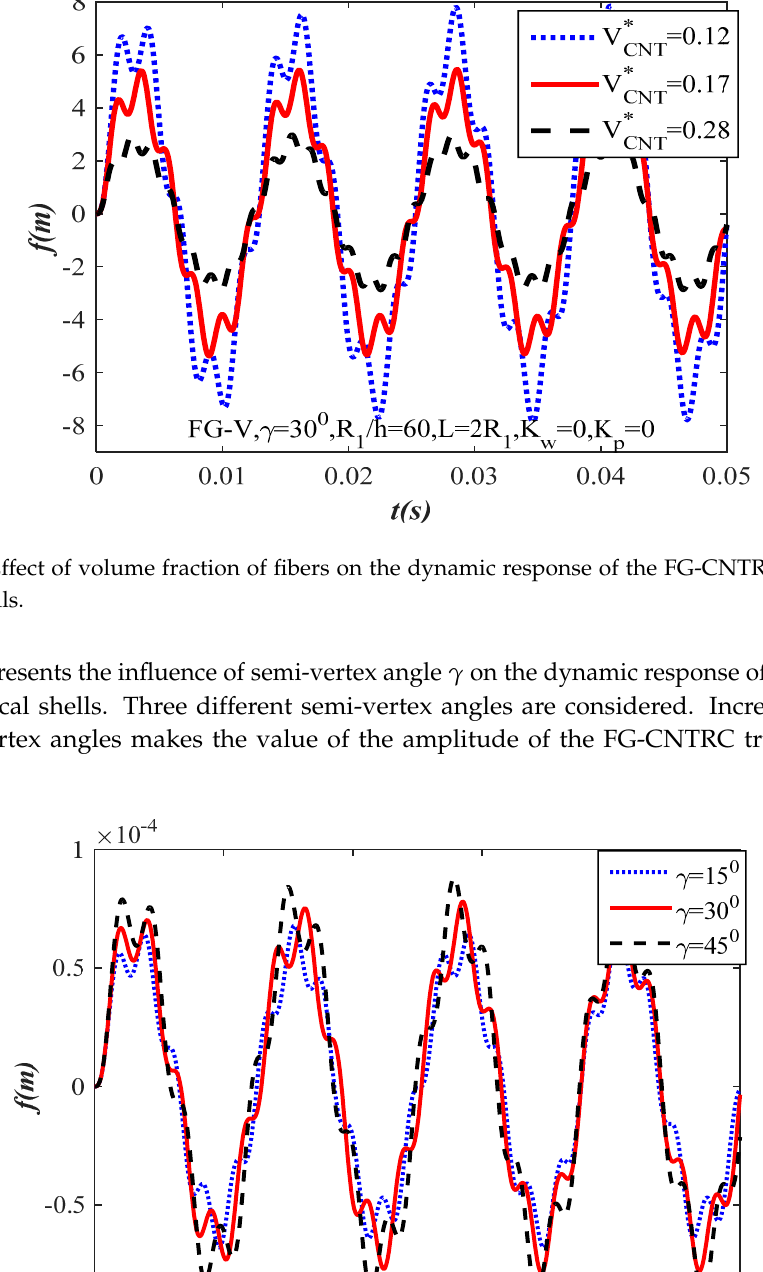
Figure 3. Effect of CNT volume fraction of fibers on the dynamic response of the CNTRC truncated conical shells with uniform distribution type.